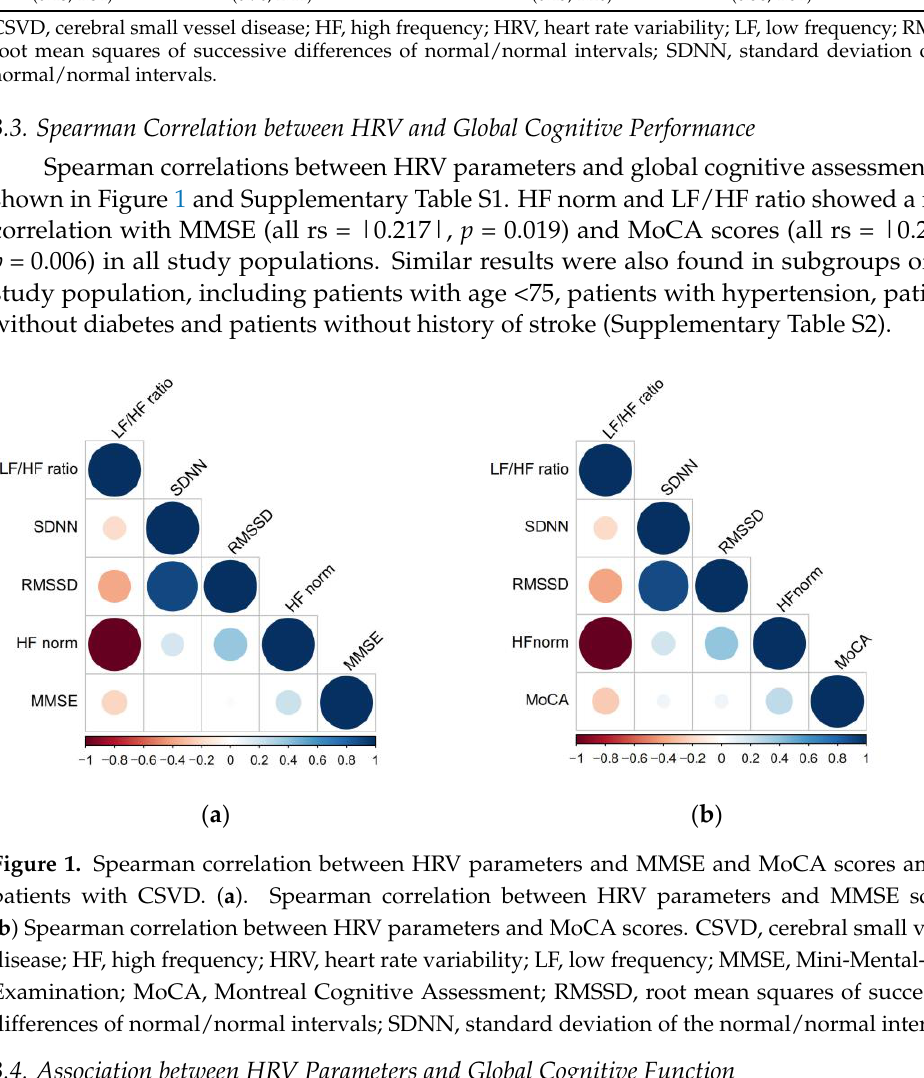
CSVD, cerebral small vessel disease; HF, high frequency; HRV, heart rate variability; LF, low frequency; RMSSD, root mean squares of successive differences of normal/normal intervals; SDNN, standard deviation of the normal/normal intervals.